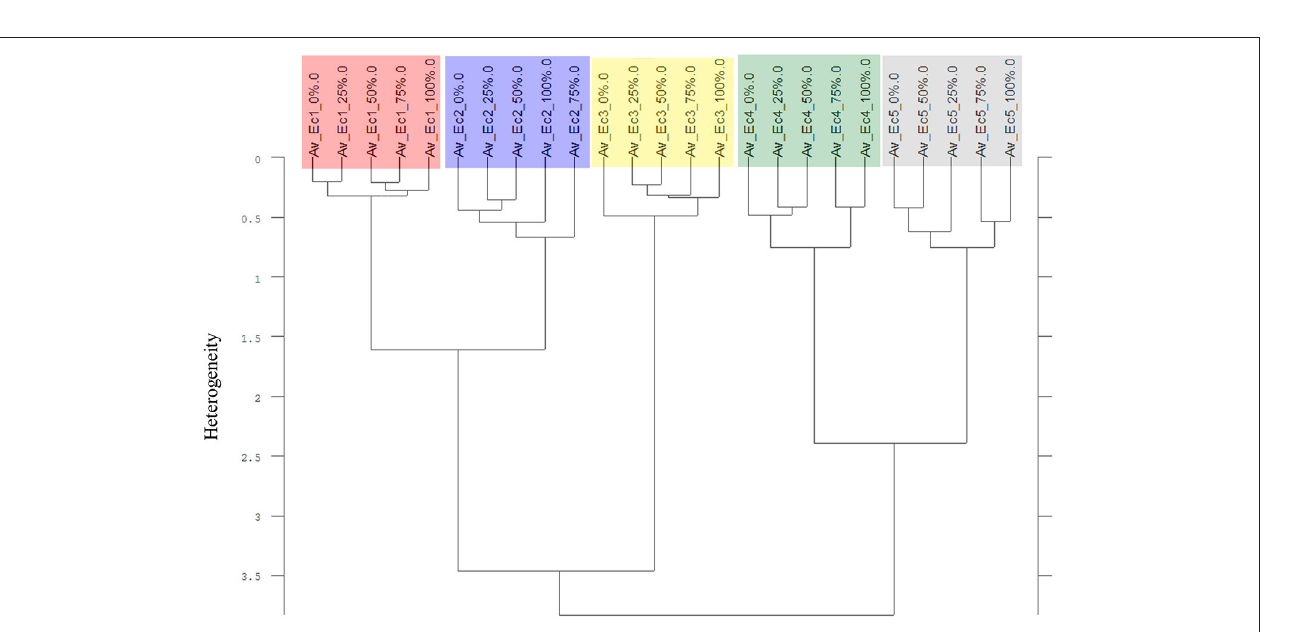
and fats. The wavenumbers 2,920 and 2,850 cm − 1 are specific for lipids (Artz et al., 2008). In that wavenumber range, the Av-spectra show differences between the species. The